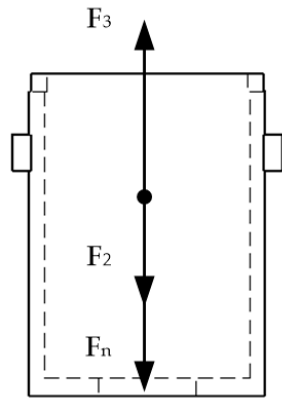
Figure 12. Force diagram of the inner sleeve. Figure 12 . Force diagram of the inner sleeve. Figure 12 . Force diagram of the inner sleeve.